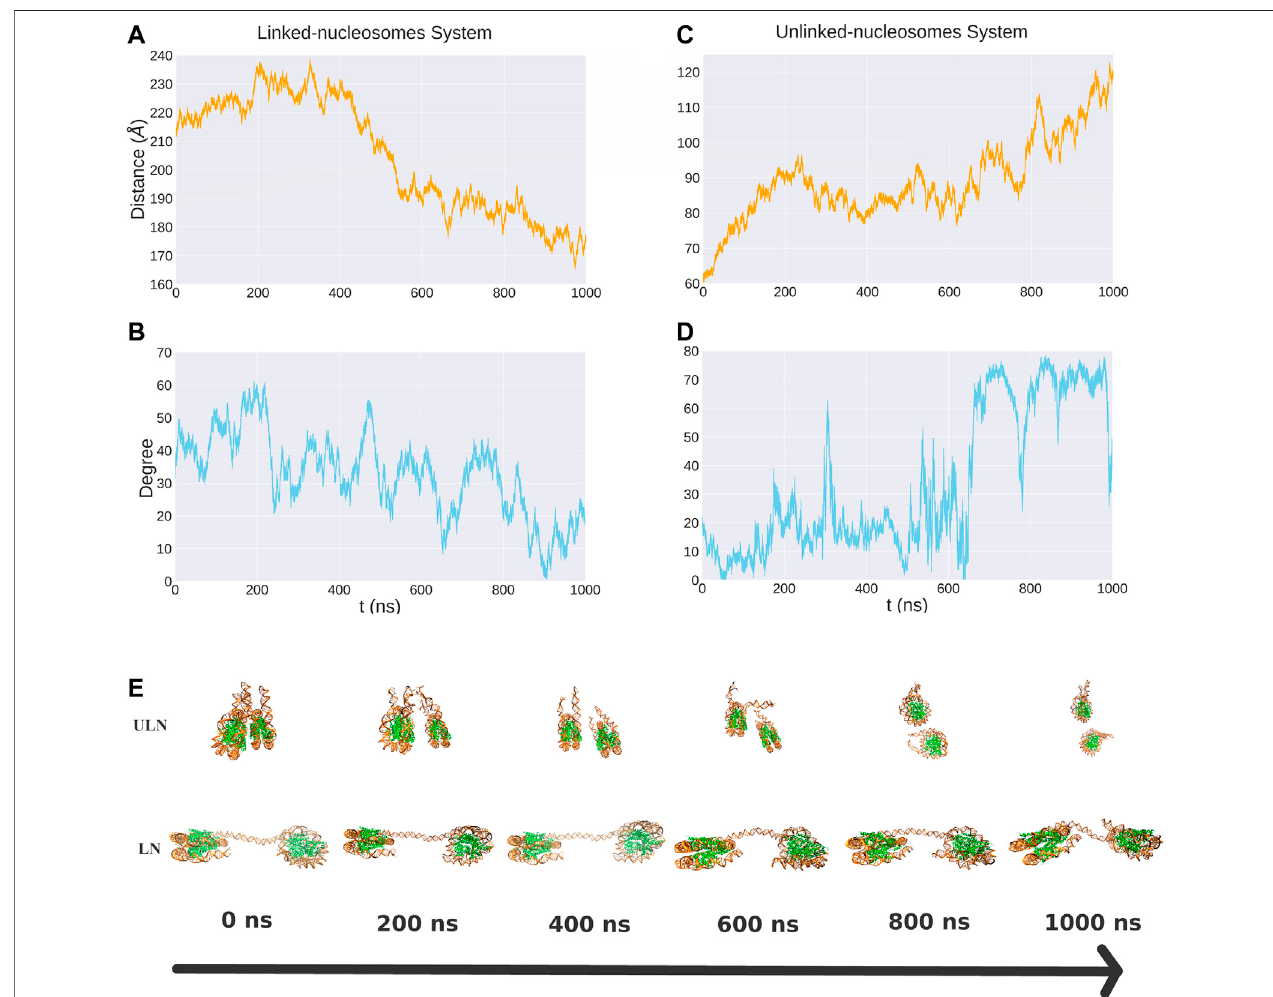
FIGURE 2 | The distance and relative orientation between two nucleosomes in the LN (A, B) and ULN (C, D) systems from 1 μ s unbiased MD simulations. Also shown are snapshots corresponding to different time points (E) .